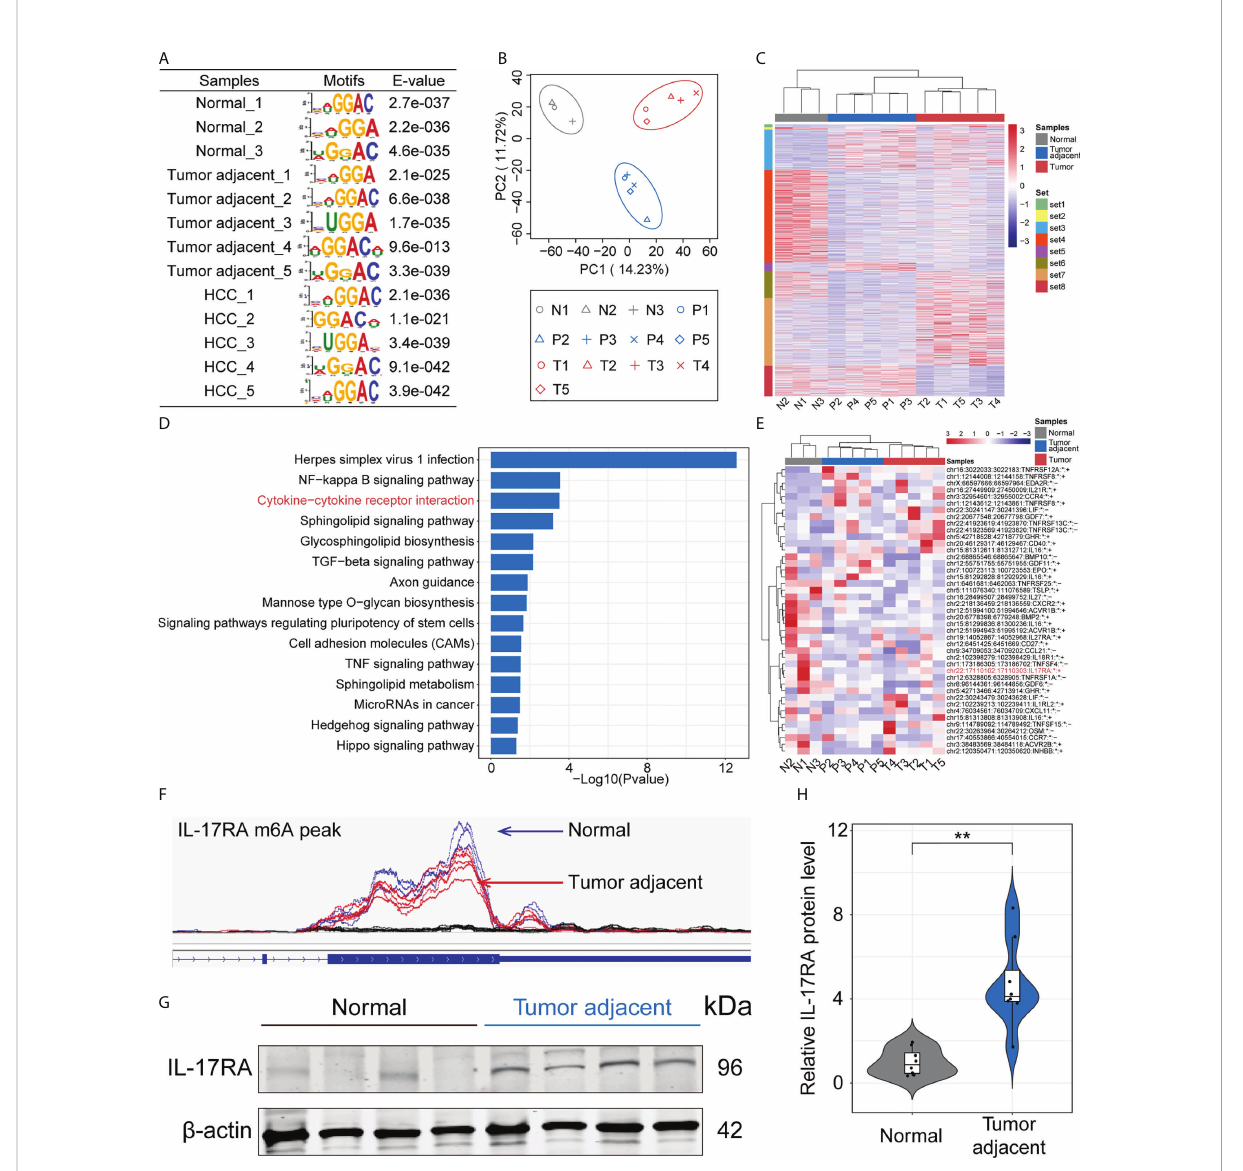
FIGURE 1 Dissecting the role of m6A mRNA methylation in the progression of HCC by MeRIP-seq. (A) Enriched RNA motifs from the m6A MeRIP-seq data within each sample. (B) PCA analysis of all samples. (C) Heatmap of m6A methylation levels of all samples. (D) KEGG analysis of differentially m6A modi fi ed genes. (E) Heatmap of differentially m6A modi fi ed genes related to the cytokine-cytokine receptor interaction. (F) m6A mRNA methylation level of IL-17RA between normal and tumor-adjacent liver tissues. (G) Western blot for the expression of IL-17RA in normal liver and tumor-adjacent liver tissues of patients. (H) Quanti fi cations of IL-17RA expression in different tissues by Western blot. ** p <